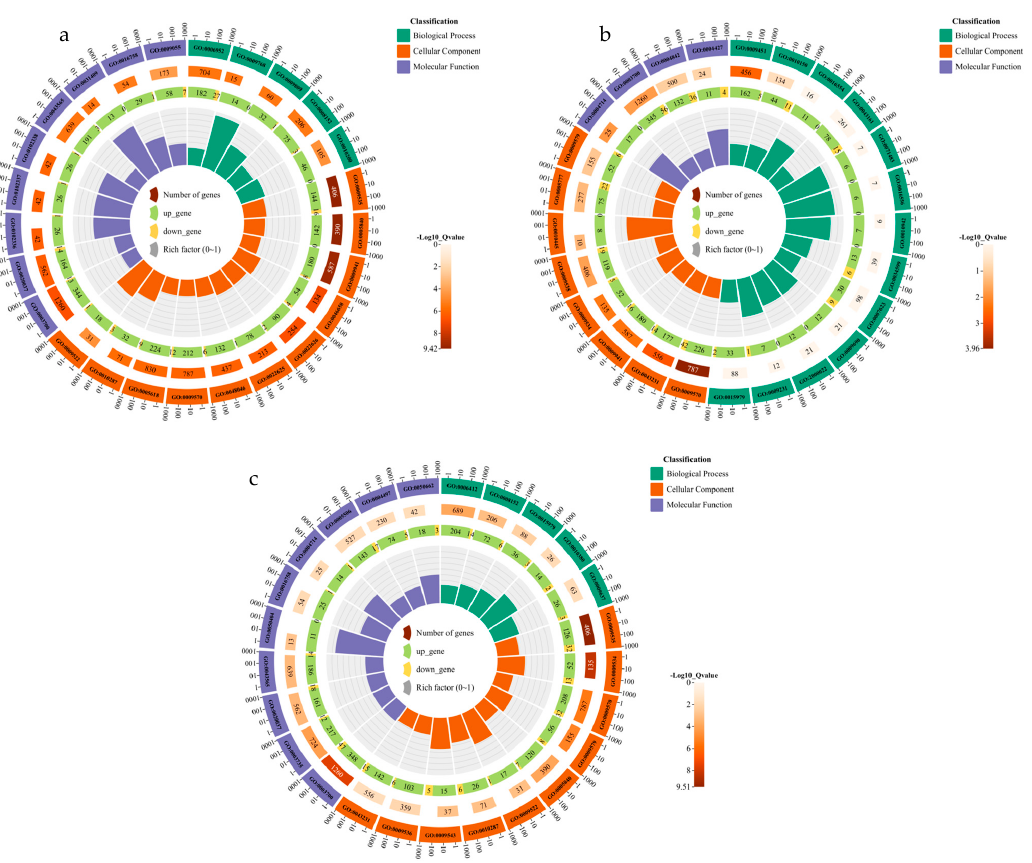
Figure 3. Enrichment analysis of the first 25 terms differentially expressed genes. ( a ) CK VS MJ50; ( b ) CK VS MJ100; ( c ) CK VS MJ250.